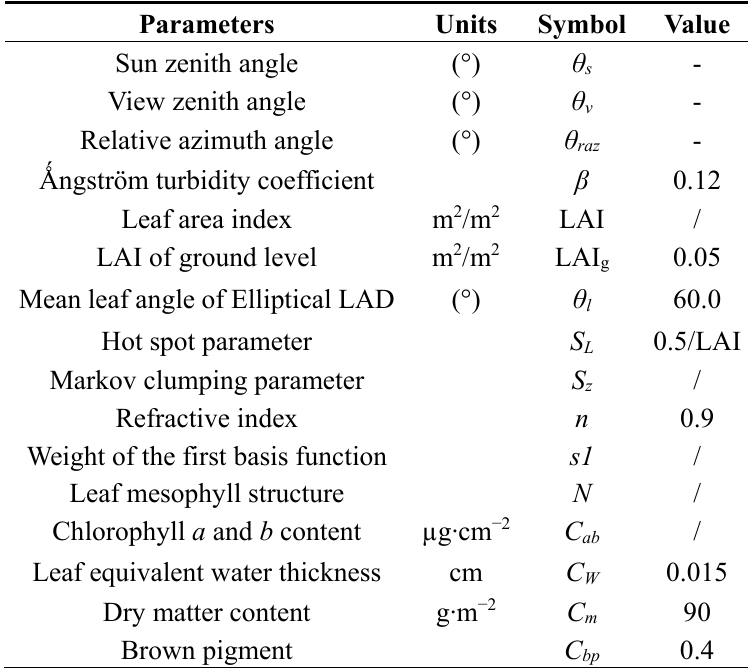
Table 1. Inputs to the ACRM.